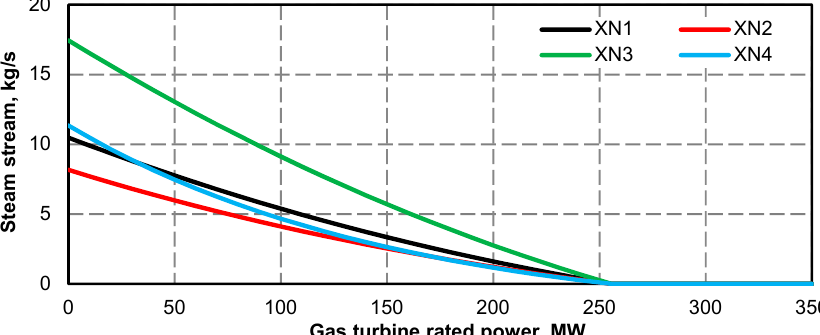
Figure 6. The streams of extraction steam for the XN1–XN4 low-pressure regeneration exchangers for a maximum fixed stream of 319.4 kg/s fresh steam fed to the steam turbine as a function of gas turbine rated power.